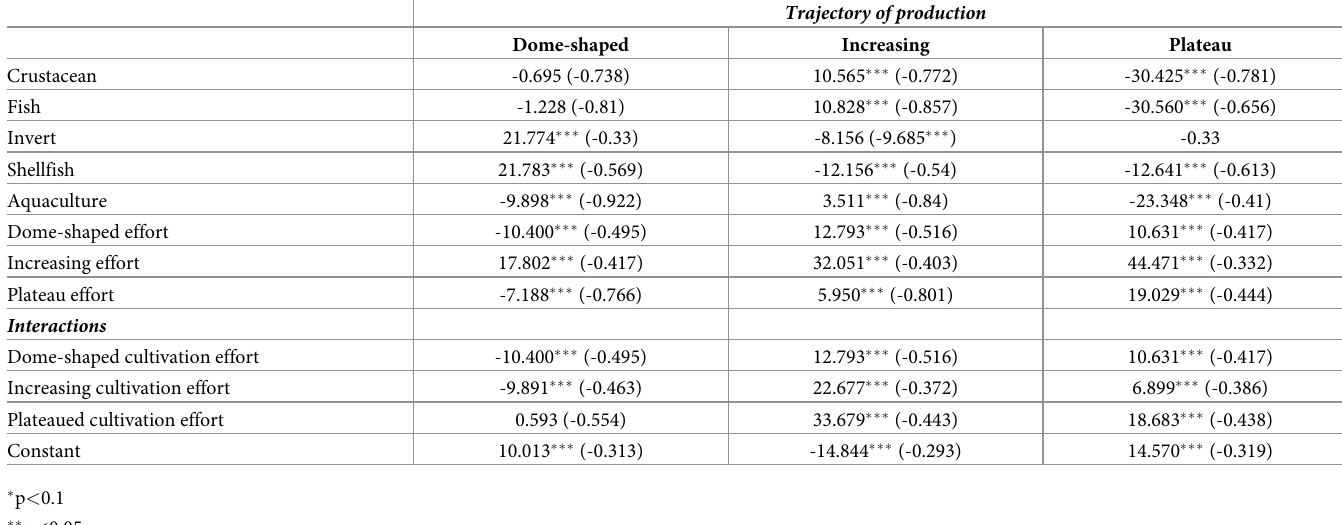
Table 1. Predicting trajectory of production by factors (product type, production mode, effort, and the interaction between production mode and effort). Reported numbers are the coefficient associated with a given trajectory for a given factor, relative to the reference trajectory (‘decreasing’) and factor (e.g. product types are relative to ‘algae’). Coefficients can be interpreted to represent the magnitude and direction of the effect of a given category relative to the reference. For example, crustaceans are significantly more likely to have increasing or plateauing production trajectories than algae, when controlling for other factors. Numbers in parentheses are the standard errors of the estimated coefficient. Standard errors are not shown when the sample size for a given combination is too small to calculate them. Asterisks indicate significant